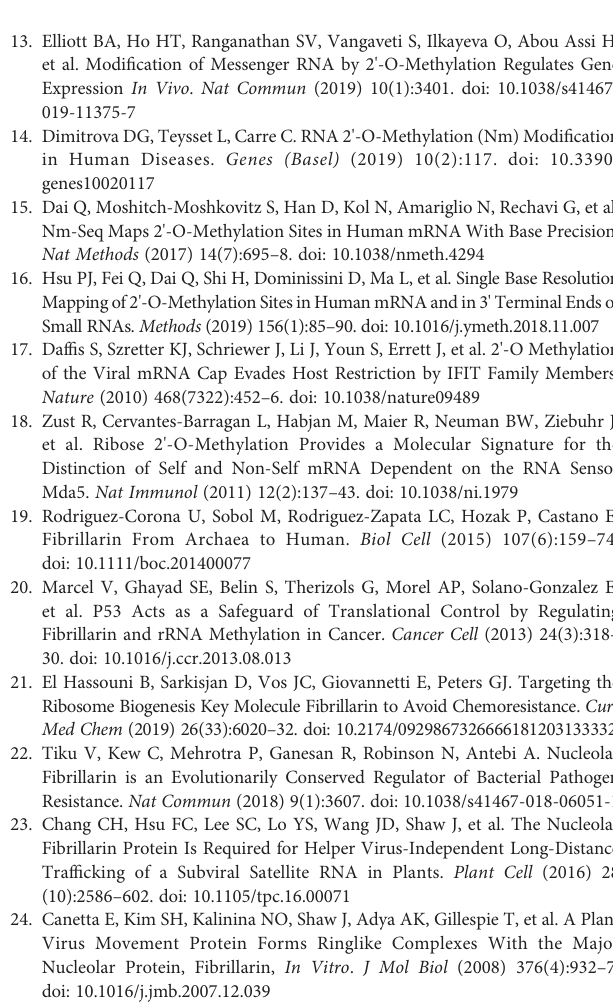
Supplementary Table 2 | siRNA sequences used for RNA interference. Supplementary Table 3 | Gradient elution procedure. Supplementary Table 4 | Methylated_sites in mRNA of RAW264.7 cells. Supplementary Table 5 | Up-regulated Nm sites after VSV